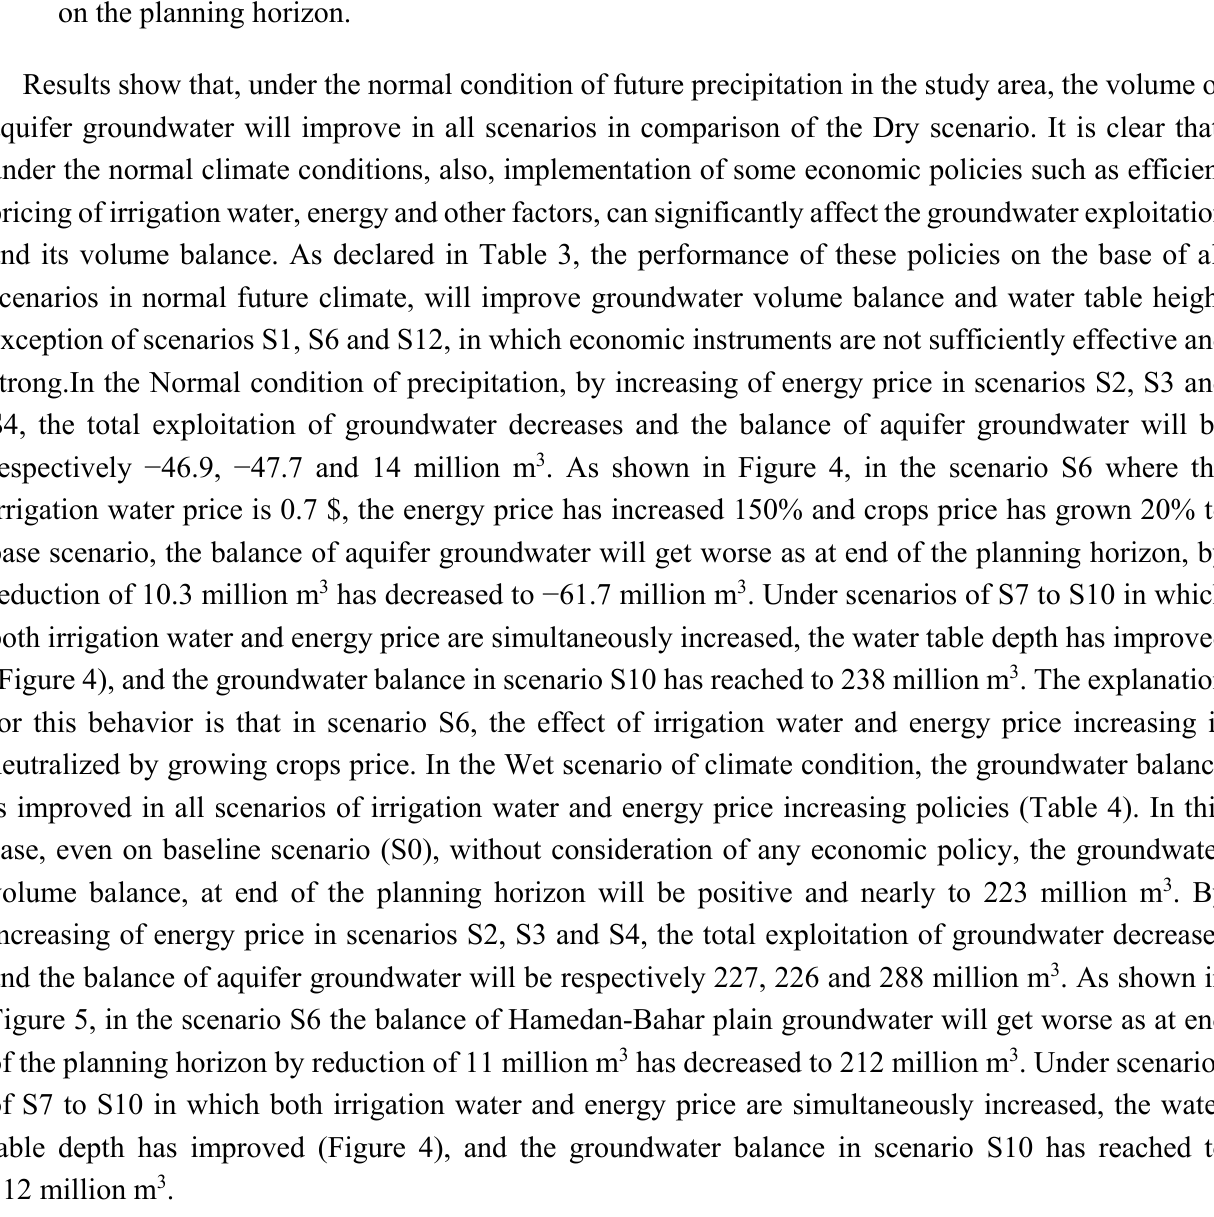
Figure 3. Height of water table under different economic scenarios in Dry climate condition on the planning